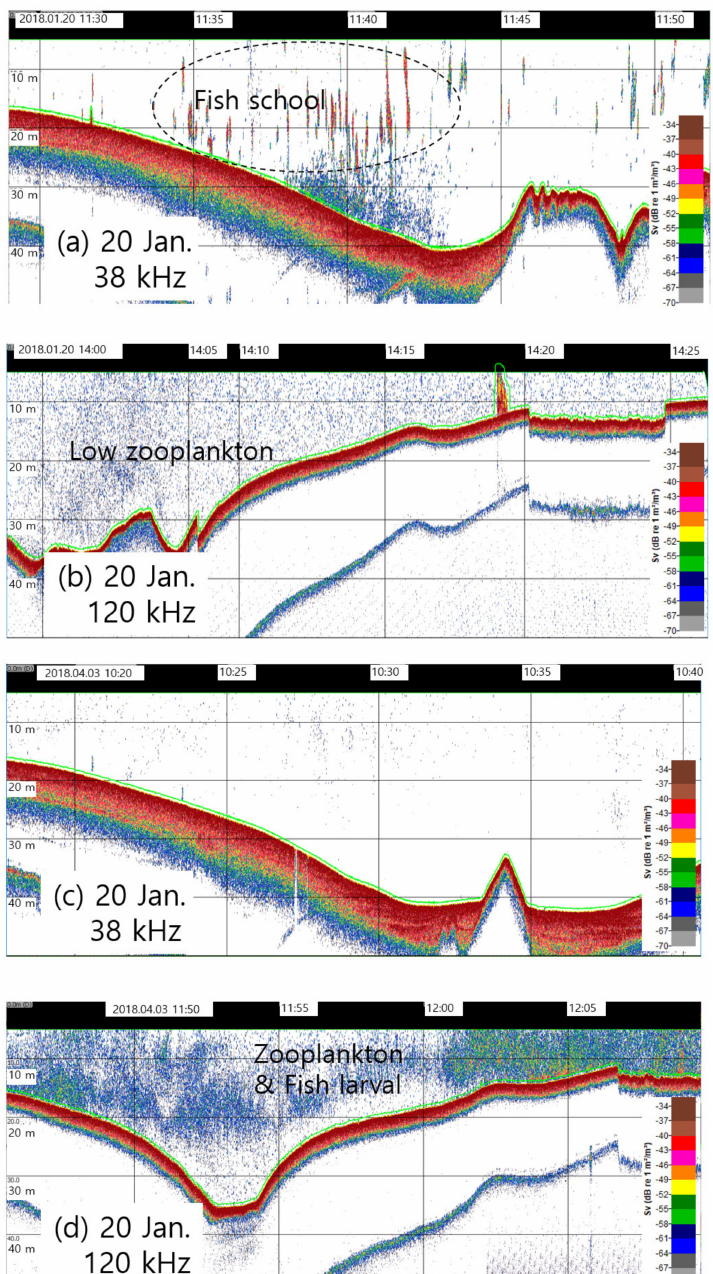
Figure 5. Examples of vertical echograms from the ship-type echosounder measured at 38 kHz ( a ) and 120 kHz ( b ) on 20 January 2018, and at 38 kHz ( c ) and 120 kHz ( d ) on 3 April 2018, in Jinhae Bay. In January, the 38 kHz echogram showed fish schools on the outside bay ( a ), and the 120 kHz echogram showed weak scatter in the inner bay ( b ). In April, the 38 kHz echogram showed no fish echoes in the outer bay ( c ), and the 120 kHz echogram showed dense scattering, indicating zooplankton and fish larvae in the inner